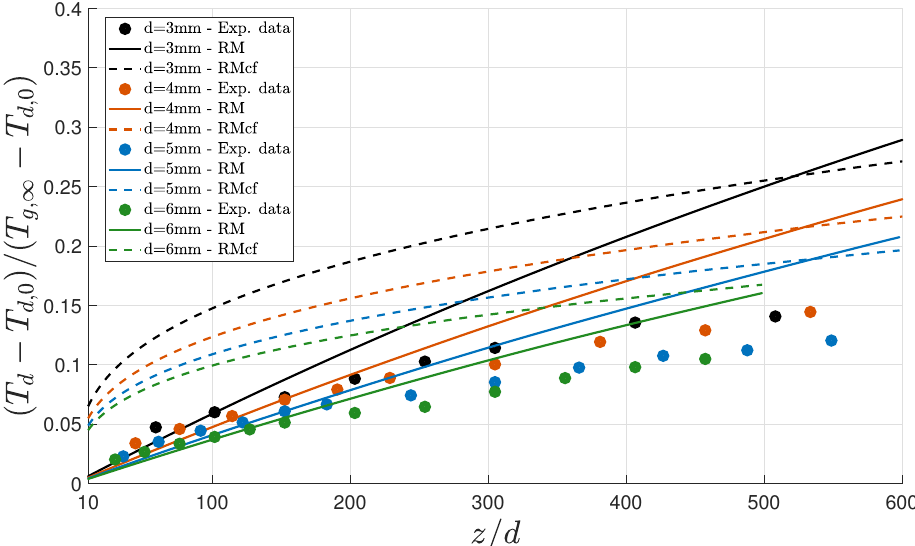
Figure 6. Variation in the temperatures of single water droplets falling through the air, subjected to a humidity ratio of